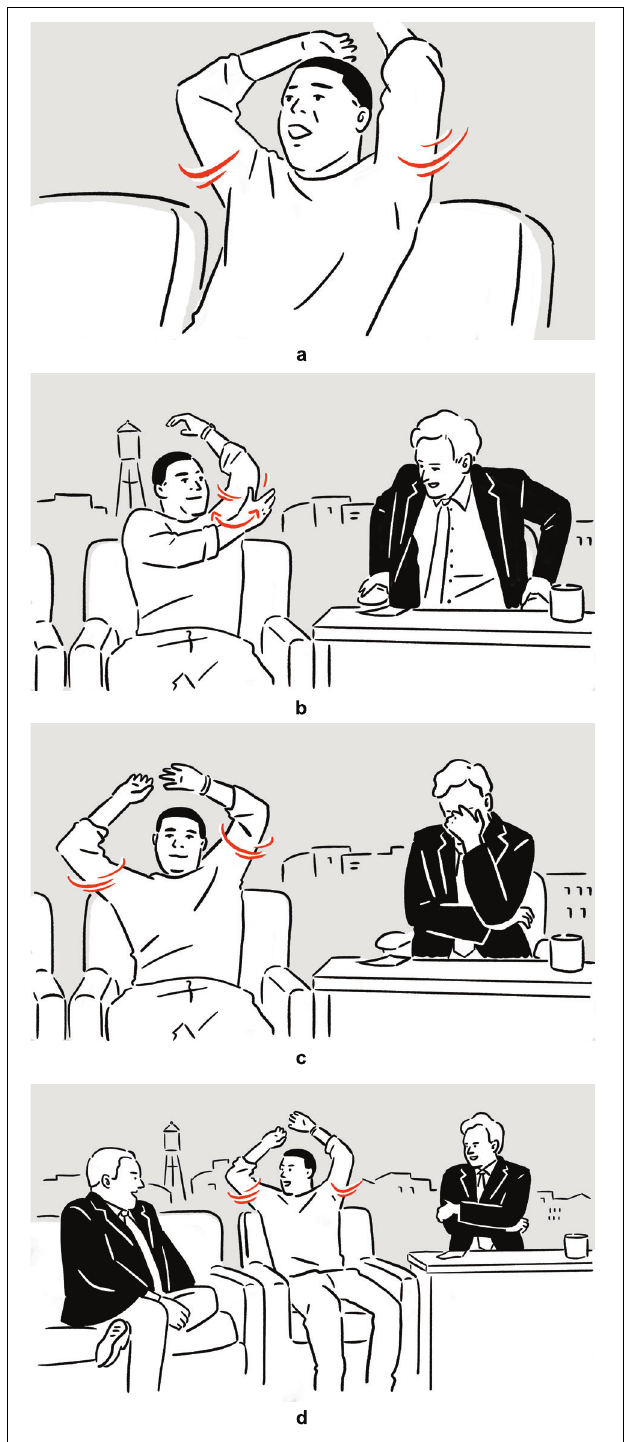
FIGURE 3 | Depictions in